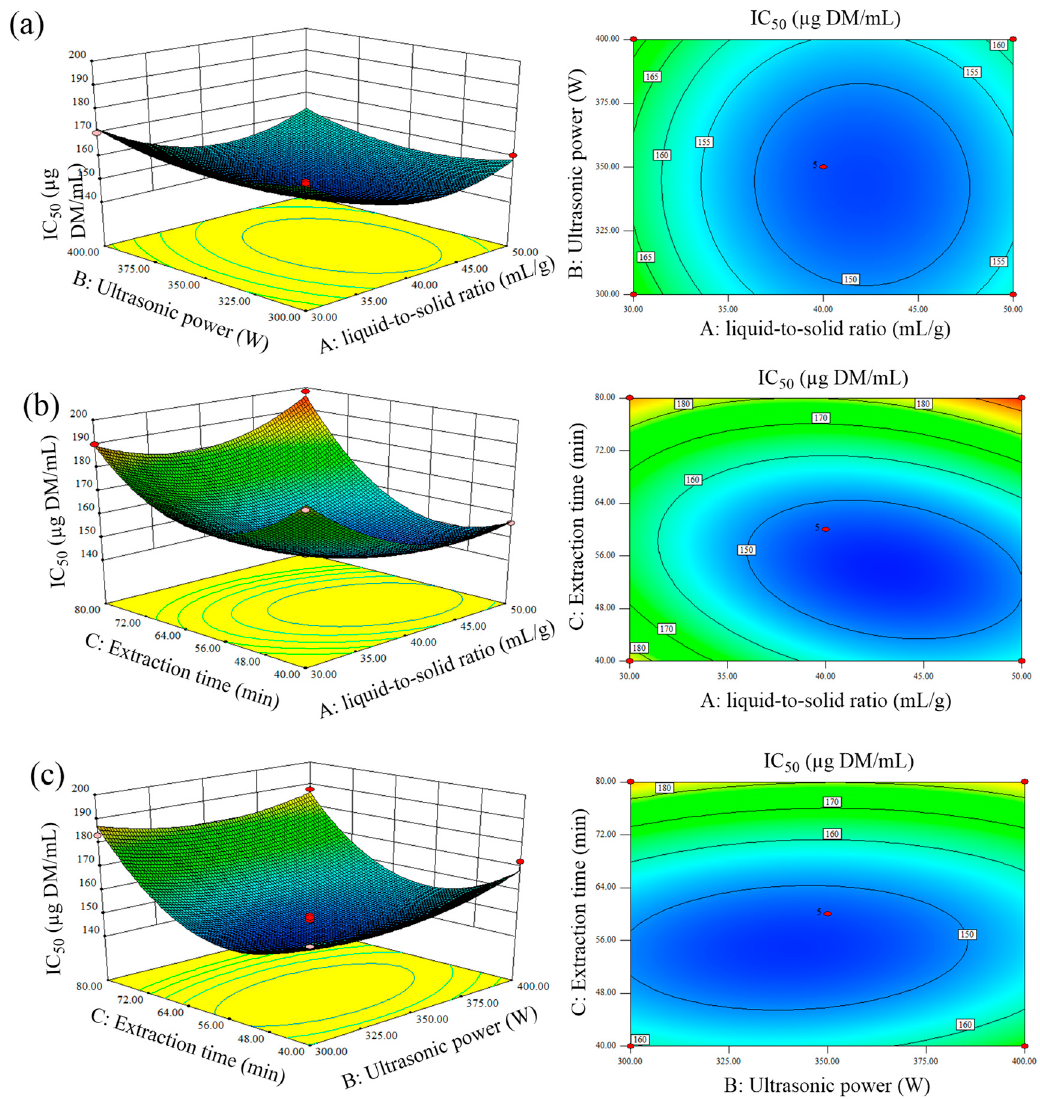
Figure 3. 3D surface plot and contour map showing the interaction effects of ( a ) liquid-to-solid ratio and power, ( b ) liquid-to-solid ratio and time, ( c ) time and power on IC 50 .